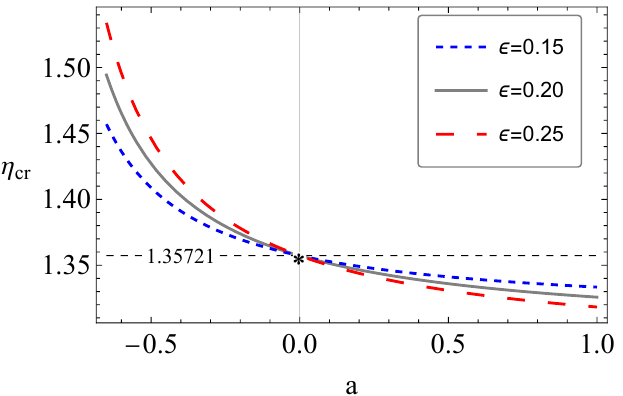
Figure 6. The critical distance η cr as a function of the EU parameter a for various values of the compactness parameter.The symbol * implies general relativistic case.